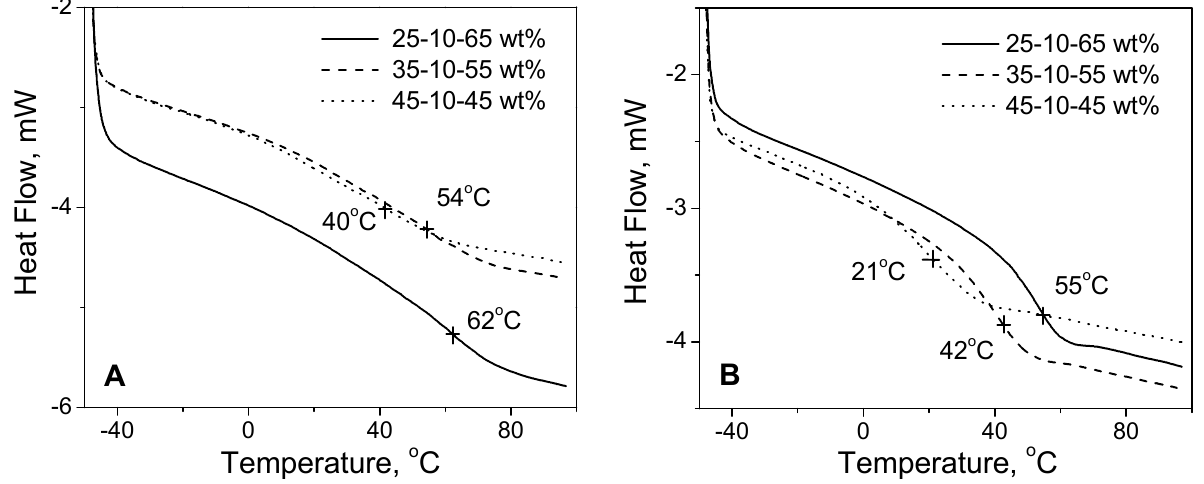
Figure 5. DSC diagrams for terpolymers HOSBM-BA-MMA ( A ) and HOSBM-BA-St ( B ) (heating rate: 10 °C min − 1 ).